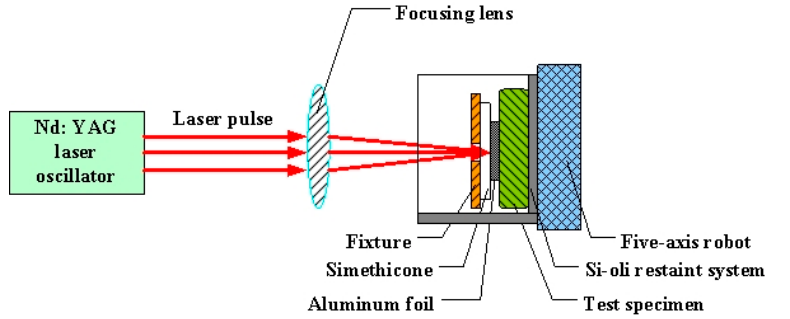
Figure 2. A schematic view of LSP assisted by DSA processing. Table 2. Parameters of the Nd:YAG-GAIA laser.